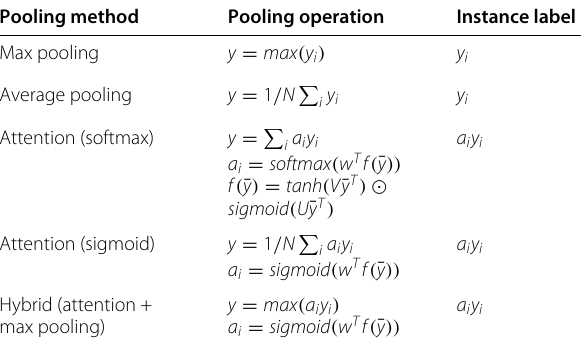
Table 1 Different MIL pooling methods for FG localization where, ¯ y = [ y 1 , y 2 , ..., y N ]